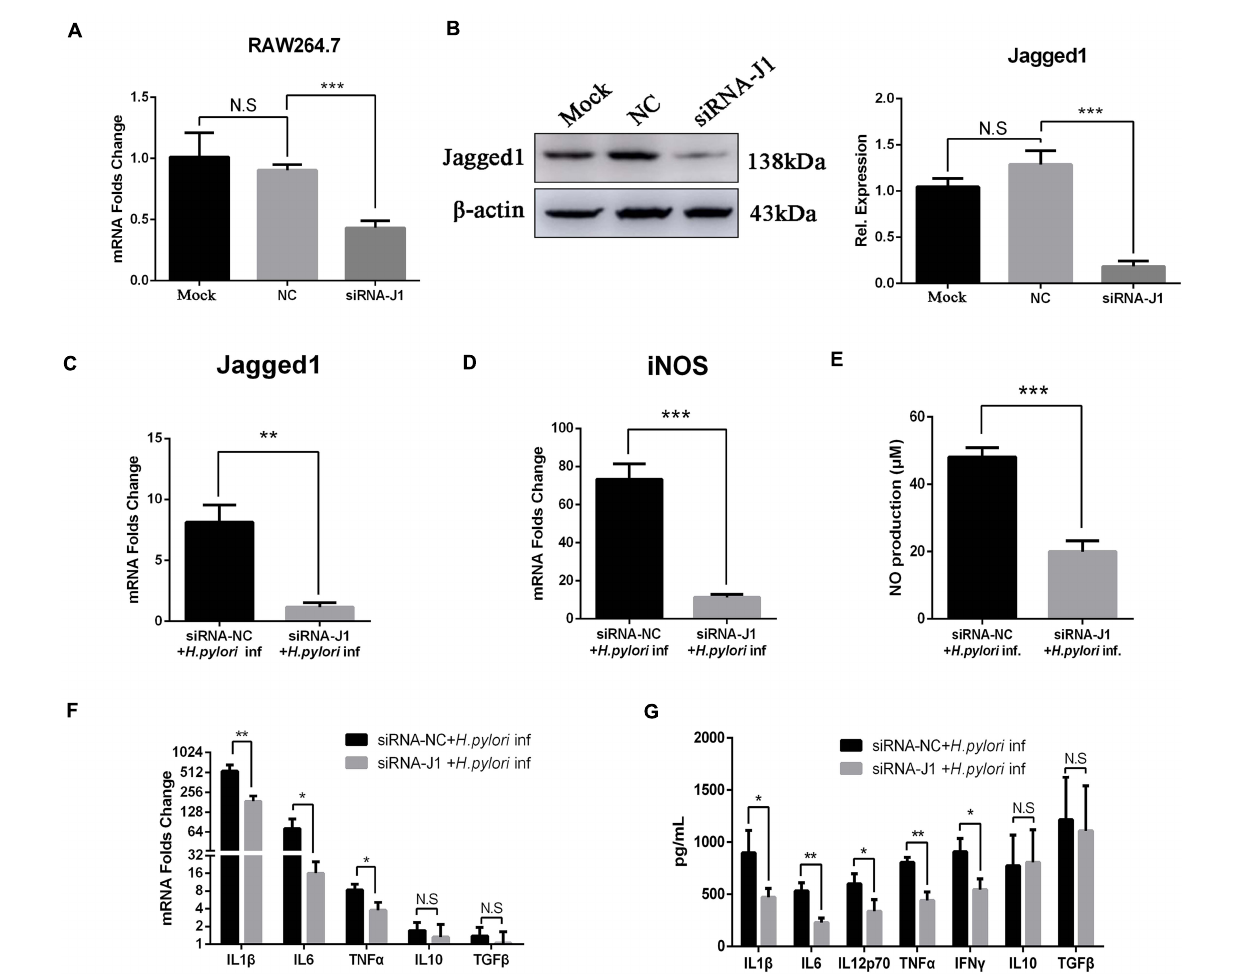
FIGURE 6 | Downregulation of Jagged1 by siRNA decreases the secretion of pro-inflammation mediators in RAW264.7 cells against H. pylori . siRNA-J1 (200 nM) was mixed with 2 µ l of Lipofectamine 3000. Then, the complex was transfected into RAW264.7 cells for 24 h and then co-cultured with H. pylori (MOI = 50) for 12 h. Lipofectamine 3000 and siRNA-NC were used as blank control (Mock) and negative control (NC), respectively. PBS was used as control for H. pylori infection. (A) Total RNA was extracted after 24 h. qPCR was performed to assess the mRNA expression level of Jagged1. (B) Total proteins were extracted after 48 h, and Western blotting was performed to assess the protein expression level of Jagged1. The resulting bands were analyzed by Gel-pro Software, generating the value of the (IOD). (C) qPCR was performed to assess the mRNA expression level of Jagged1 in H. pylori -stimulated RAW264.7 cells that were treated with siRNA-NC or siRNA-J1 for 48 h. (D) qPCR was performed to assess the mRNA expression level of Jagged1 in H. pylori -stimulated RAW264.7 cells that were treated with siRNA-NC or siRNA-J1. (E) Griess was performed to assess the production of NO in the supernatant. (F) qPCR was performed to examine the mRNA expression of proinflammatory cytokines IL-1 β , IL-6, and TNF- α and anti-inflammatory cytokines IL-10 and TGF- β . (G) ELISA was performed to examine the protein expression levels of pro-inflammatory cytokines IL-1 β , IL-6, IL-12p70, TNF- α , and IFN- γ and anti-inflammatory cytokines IL-10 and TGF- β in the supernatant. β -actin was used as reference gene. Data are presented as the mean ± SD of three independent experiments. * p < 0.05, ** p < 0.01 and *** p < 0.001; N.S. represents no significant difference.